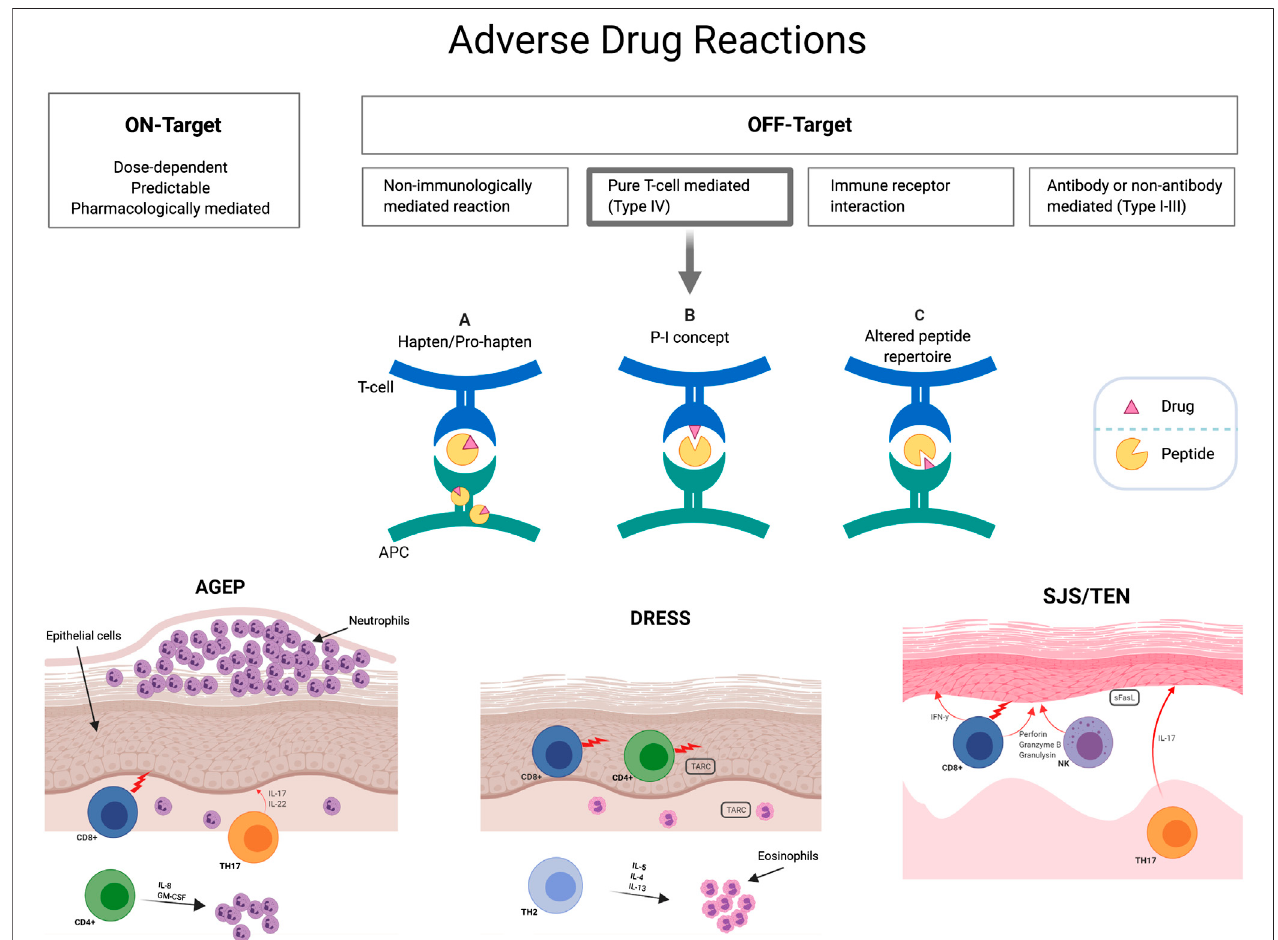
FIGURE 1 | T-cell mediated delayed hypersensitivity mechanistic hypotheses. Three non-mutually exclusive hypotheses have been described to clarify drug triggered T-cell activation: (A) The hapten/prohapten model describes how an antigen (drug) that covalently binds to a self-peptide is intracellularly processed and then presented by MHC to T cells. (B) The p-i concept (pharmacological interaction with immune receptor) is based upon non-covalent binding of antigens to HLA or TCR without immune processing. (C) The altered repertoire model indicates that drugs can occupy positions in the peptide binding groove of the MHC, altering the binding cleft and the speci fi city of MHC binding. HLA, human leukocyte antigens; MHC, major histocompatibility complex; TCR, T-cell